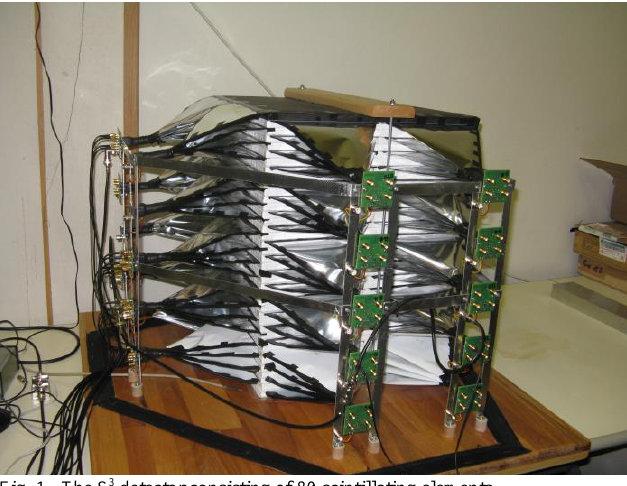
Fig. 1. The S 3 detector consisting of 80 scintillating elements. Each scintillating element is covered by the 800 μm thick Teflon layer working as a reflective material. The Teflon layer ensures 1.6 times better light yield in comparison with the bare scintillator and 80% homogeneity of the light collection along the scintillating element. Scintillating elements are arranged in the detector so that each layer (2 elements) lies perpendicularly to the previous one thus forming X-Y structure. Between each two layers there is a neutron conversion layer based on Gd 2 O 3 ,